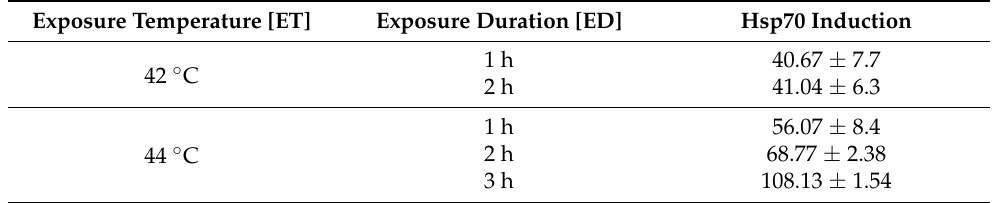
Table 2. Heat-stress model of DBMSC. Hsp70 gene expression fold-change values from five circum- stance conditions involving a combination of two exposure temperatures (ET) and three exposure durations